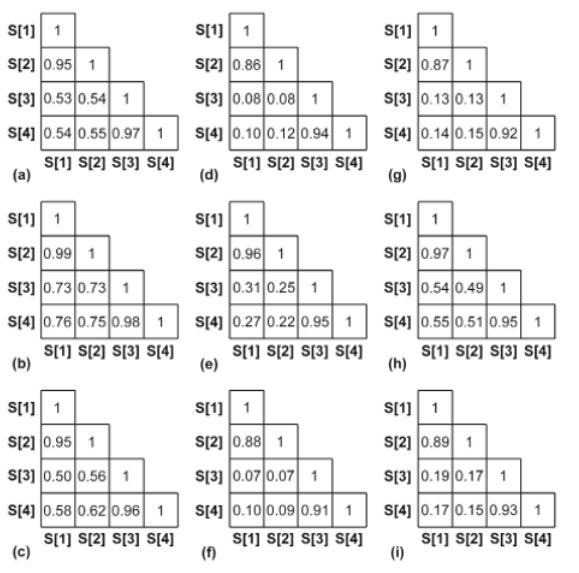
Figure 4. Nine matrices concerning the first subgroup of pharmacophores: ( a ) the ( N-A ) – ( N-A-B ), ( b ) the ( N-A ) – ( N-B-A ), ( c ) the ( N-A ) – ( A-N-B ), ( d ) the ( N-B ) – ( N-A-B ), ( e ) the ( N-B ) – ( N-B-A ), ( f ) the ( N-B ) – ( A-N-B ), ( g ) the ( A-B ) – ( N-A-B ), ( h ) the ( A-B ) – ( N-B-A ) and ( i ) the